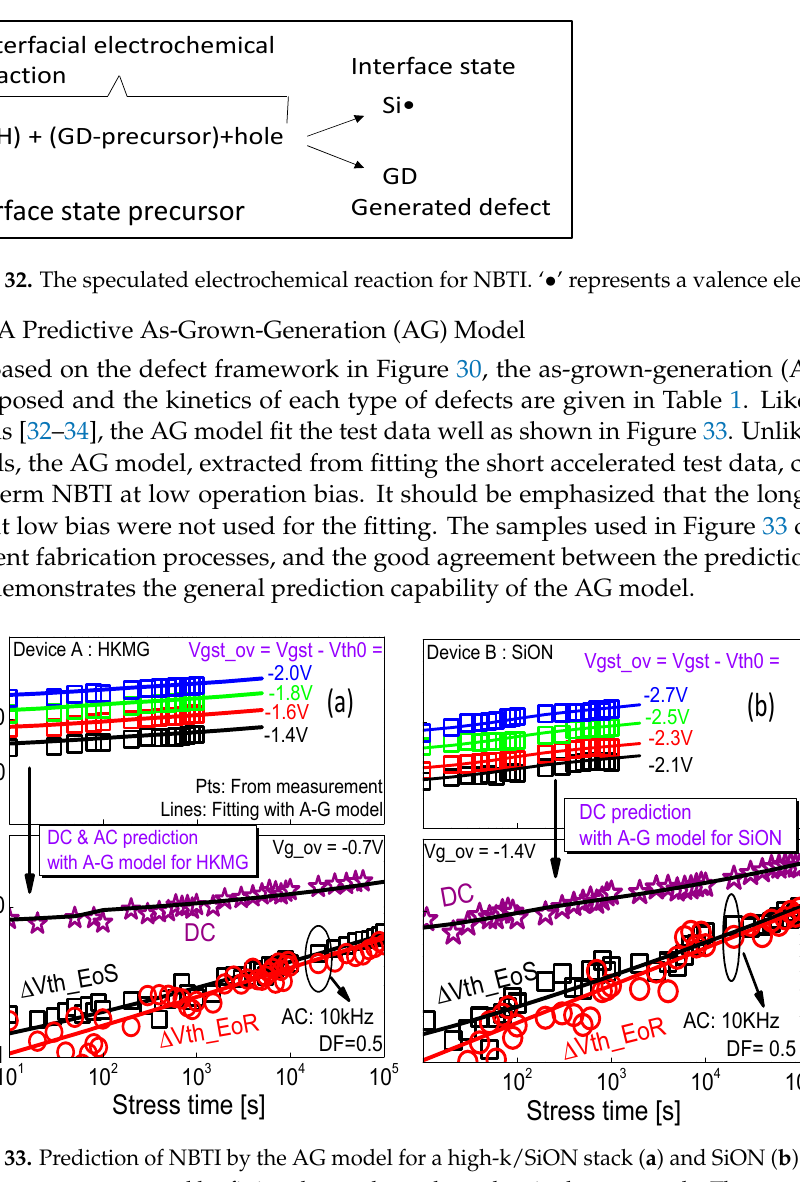
Figure 31. The one-to-one correlation between generated oxide charges and the charges from generated interface states [53].